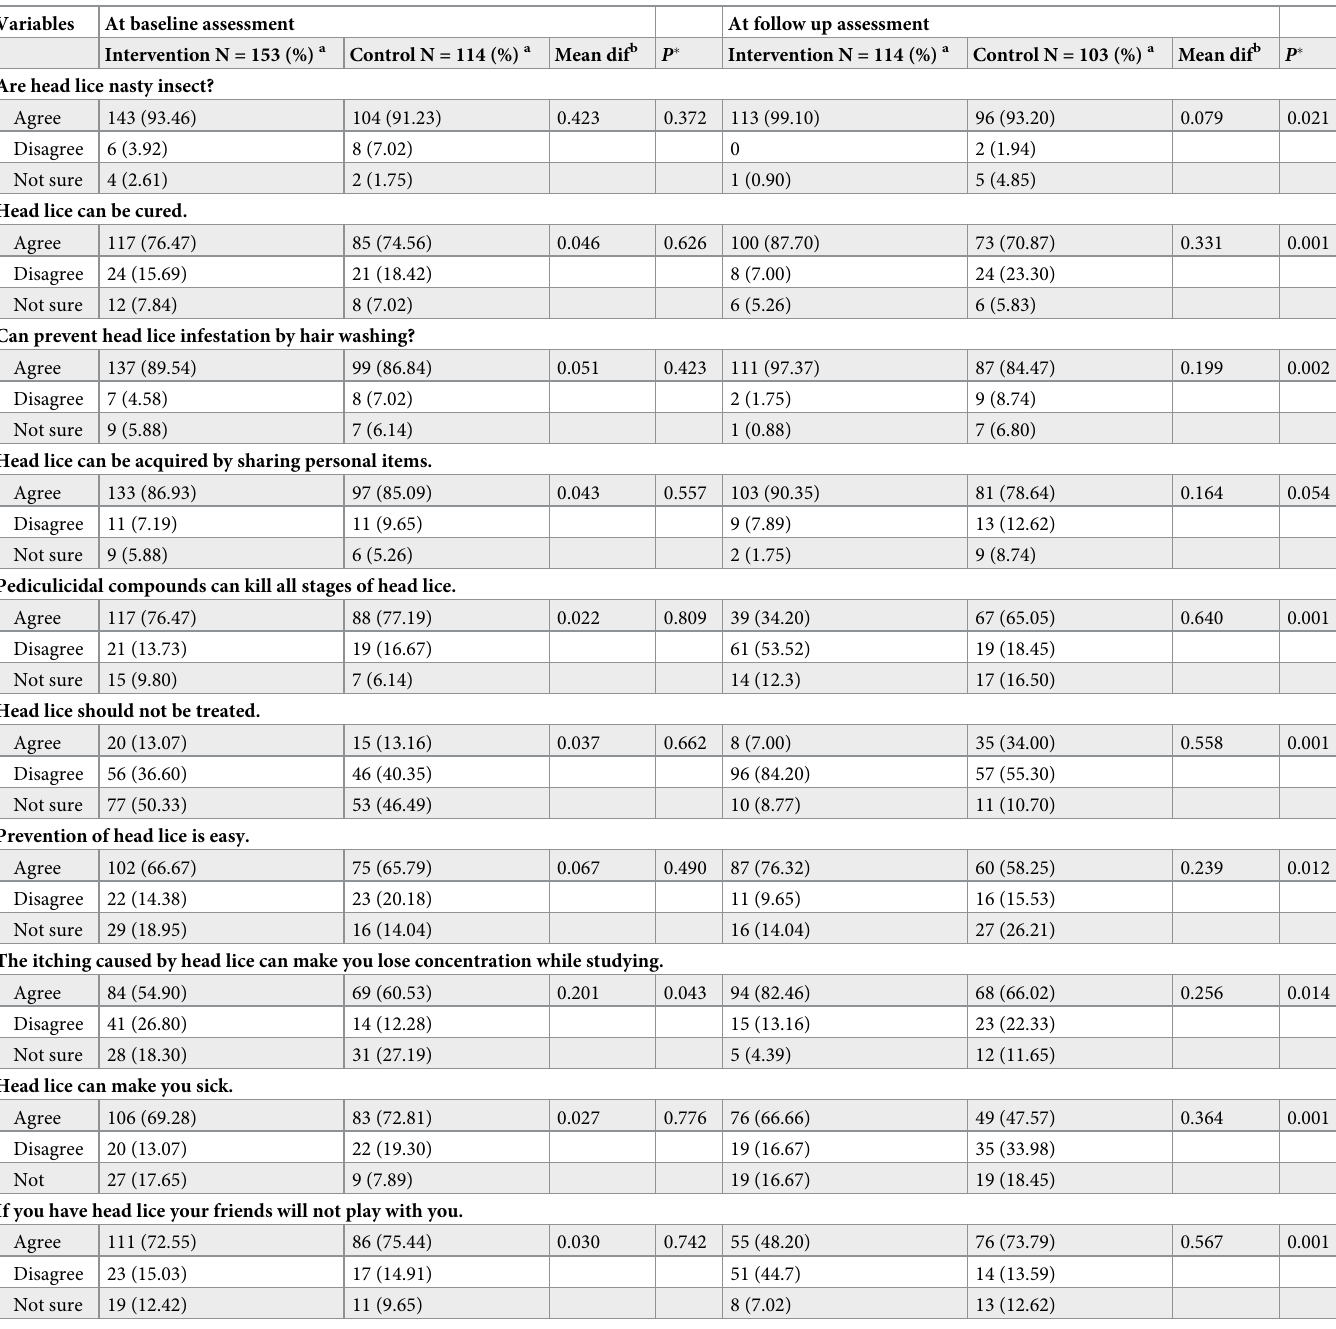
Table 4. Attitudes about head lice in intervention and control groups at baseline and at the two-month follow-up assessment. Variables At baseline